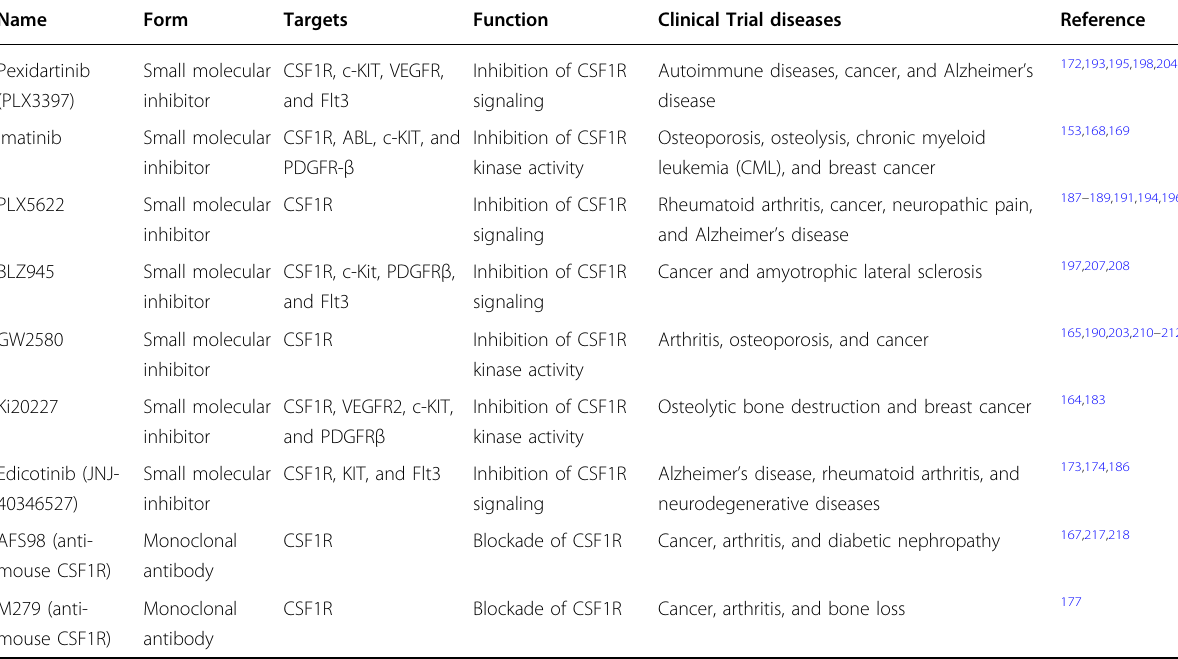
Table 1 Therapeutic applications of inhibitors and antibodies against